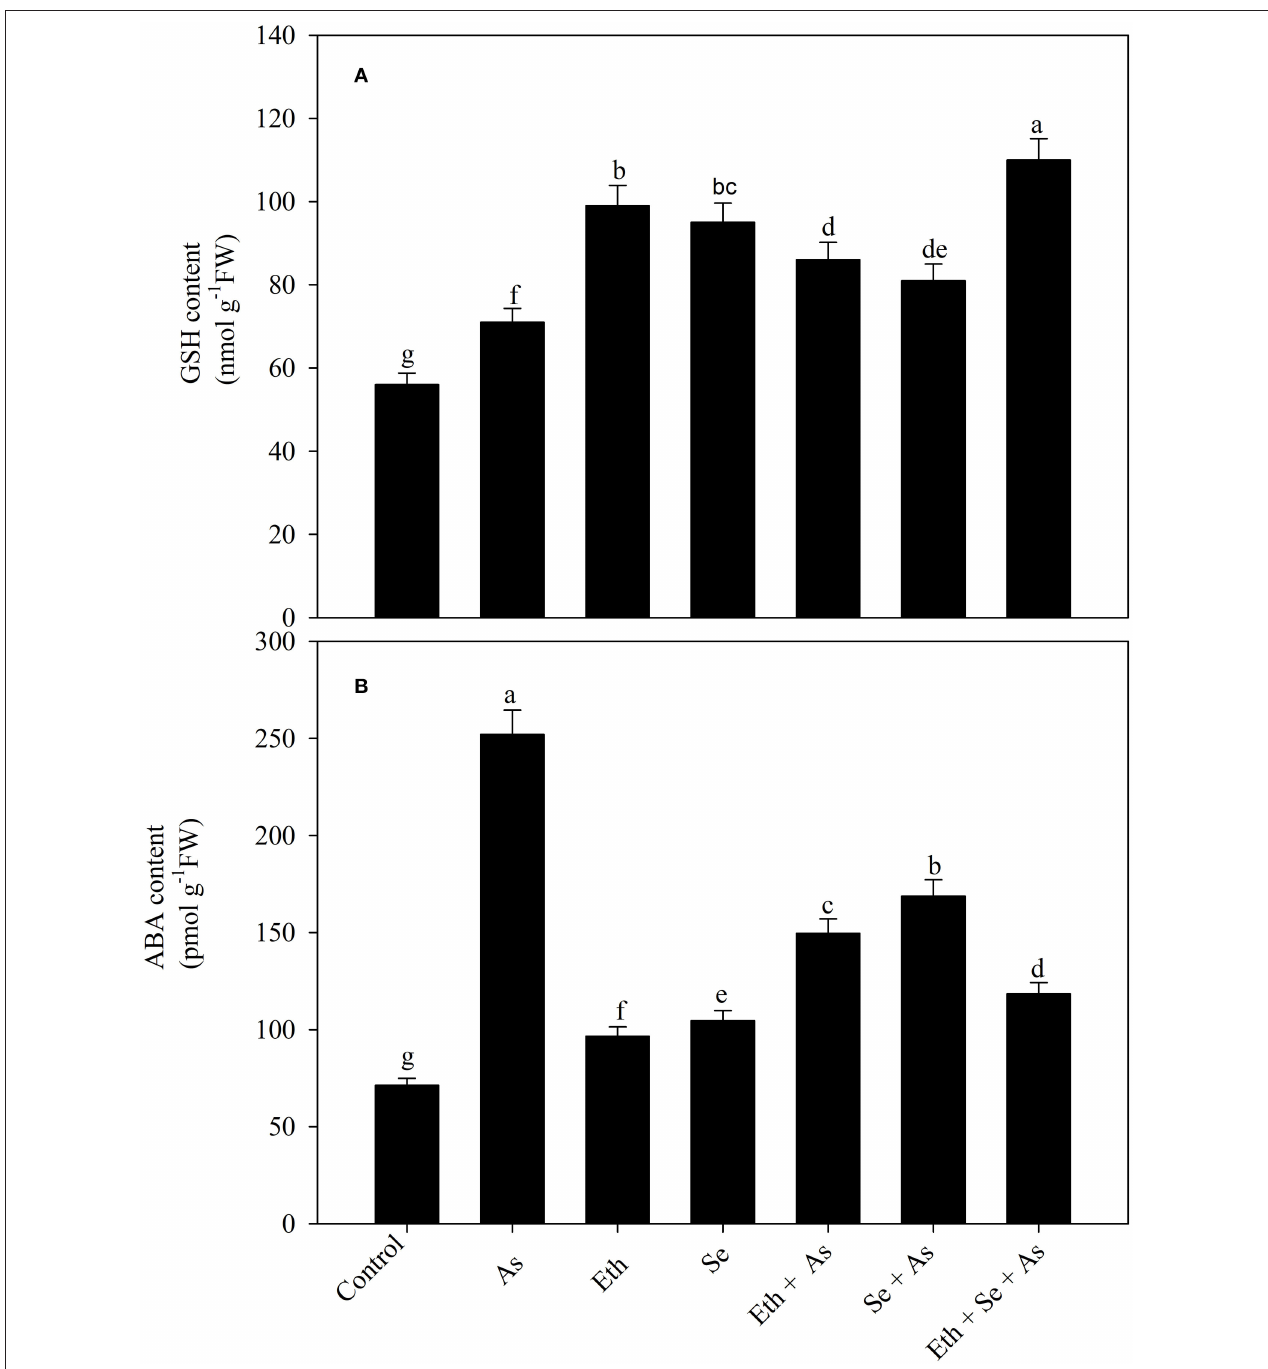
FIGURE 2 | Foliar content of GSH (A) and ABA (B) in mustard ( B. juncea L.) grown with 200 µ l L − 1 Eth and/or 2-mg Se kg − 1 soil in the presence or absence of 24-mg As kg − 1 soil at 30 DAS. Data are presented as treatment mean ± SE ( n = 4). Data followed by the same letter are not significantly different by LSD test at p < 0.05. ABA, abscisic acid; As, arsenic; Eth, ethephon; GSH, reduced glutathione; Se, selenium.